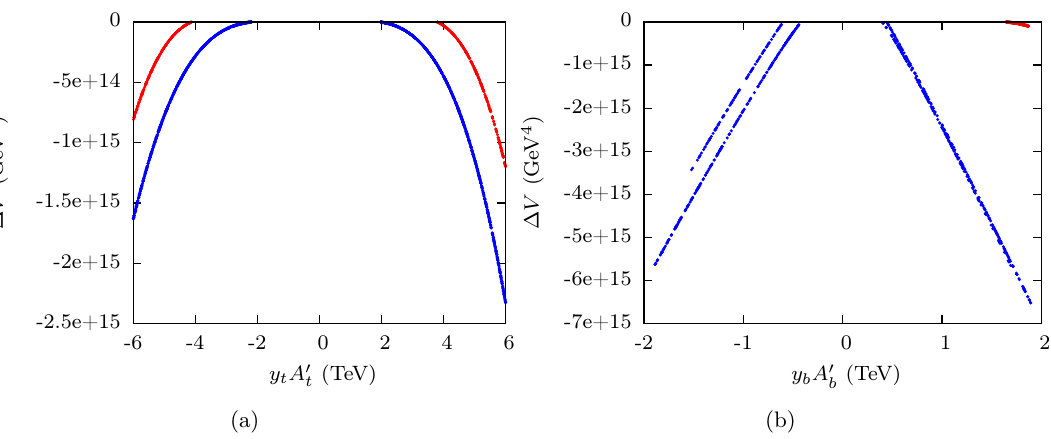
Figure 1 . (cid:1) V represents the depth of the potential at the deeper CCB vacuum with respect the to the (cid:12)eld origin. Figure 1(a) shows the variation of (cid:1) V with y t A 0 depicts the y b A 0 dependence of (cid:1) V for ~ b vevs scenario. The red and blue points correspond to b tan (cid:12) = 50 and tan (cid:12) = 5 respectively. Lowering of the potential depending on the suitable values of A 0 and A 0 is evident from the above plots. Large j A 0 t b